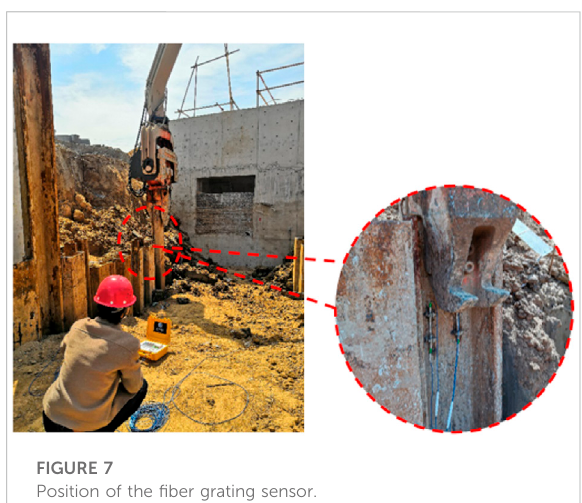
FIGURE 7 Position of the fi ber grating